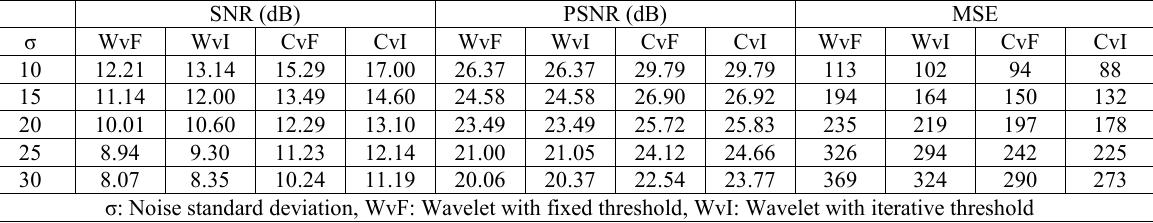
Table 1: Performance of Noise Filtering for Quickbird image